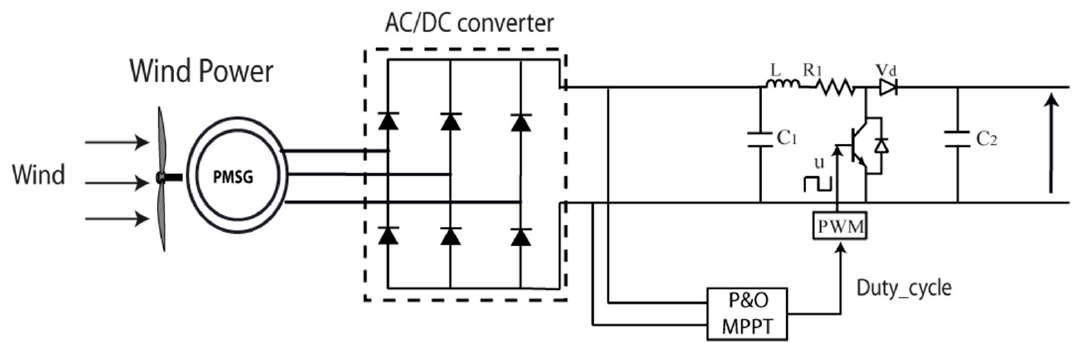
Figure 5. Wind turbine system.